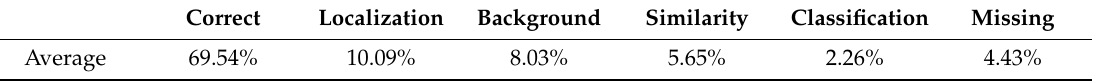
Table 6. Proportion of di ff erent types of errors across five classes of